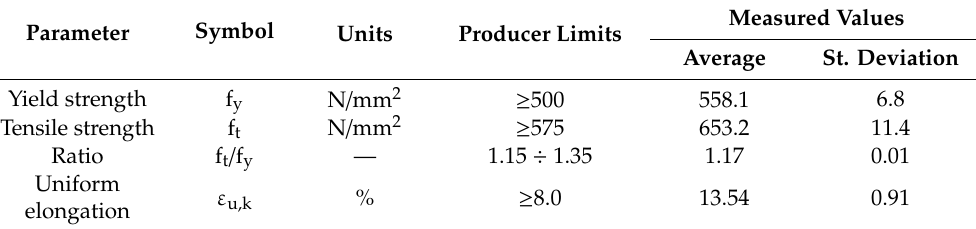
Table 2. Mechanical parameters of reinforcing bars (B500SP).